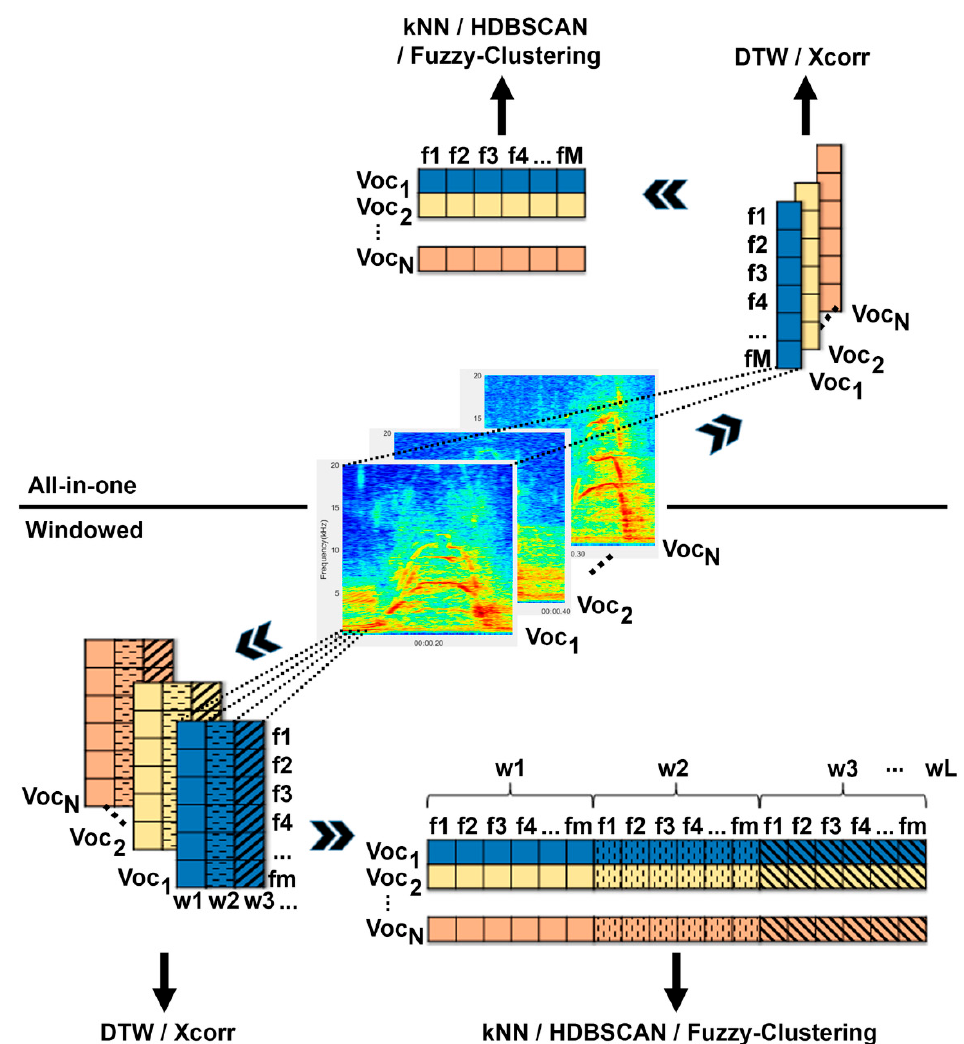
Figure 5. Process of data transformation using the All-in-one method ( upper half ) and the windowed method ( lower half ). All-in-one: For each vocalization (Voc1 to VocN) M acoustic features are extracted or M frequency domain representations are determined using FFT. These can then either be classified directly via DTW or Xcorr, or are transferred to an NxM matrix for further processing via kNN, HDBSCAN, or fuzzy clustering. Windowed: Each vocalization (Voc1 to VocN) is divided into L windows (w1 to wL) from which m acoustic features are extracted or m frequency domain representations are determined by FFT. These mxL matrices can then either be classified directly via DTW or Xcorr, or are transferred into an NxM matrix (where M = L × m) for further processing via kNN, HDBSCAN, or fuzzy